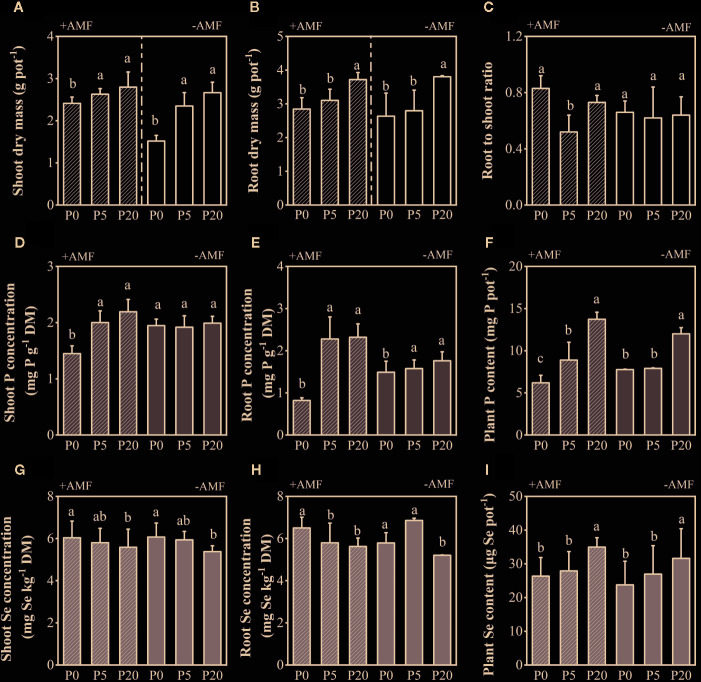
Shoot dry mass (A), root dry mass (B), root to shoot ratio (C), P and Se concentrations (D, E, G, H), total P and Se contents in plants per pot (F, I) for all treatments. Data are presented as means ± S.E. (n = 4). One-way ANOVA and Tukey’s test were performed for each AMF treatment (+AMF or −AMF). Significant differences (P < 0.05) between treatments are indicated with different letters above the bars.